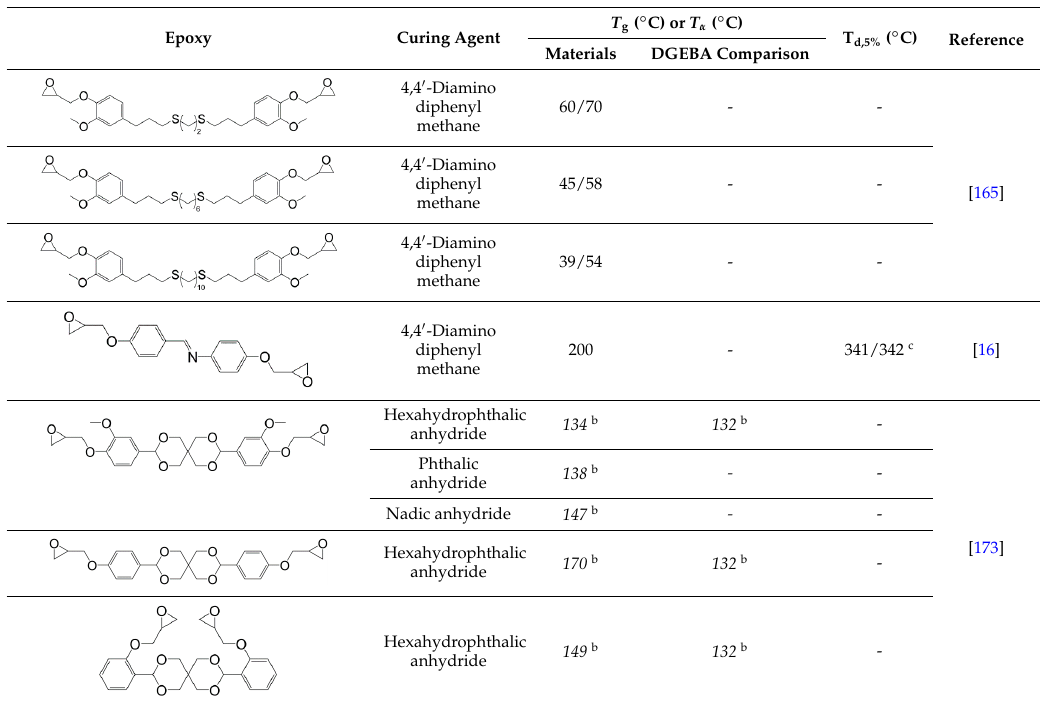
a T α measured by DMA at the peak position of loss modulus curve; tan δ ; c T d under air Table 6. Poly-aromatic epoxy monomers from crude bio-mass and thermal properties of the cured materials. Epoxy Curing Agent Epoxidized depolymerized kraft lignin